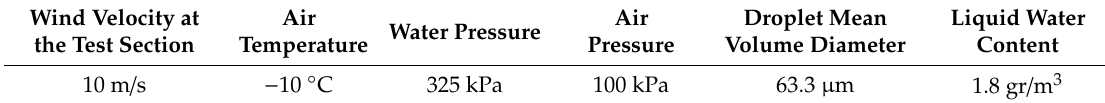
Figure 3. Schematics of the wind tunnel used for ice accumulation. Table 3. Icing conditions used in the wind tunnel for ice accumulation.